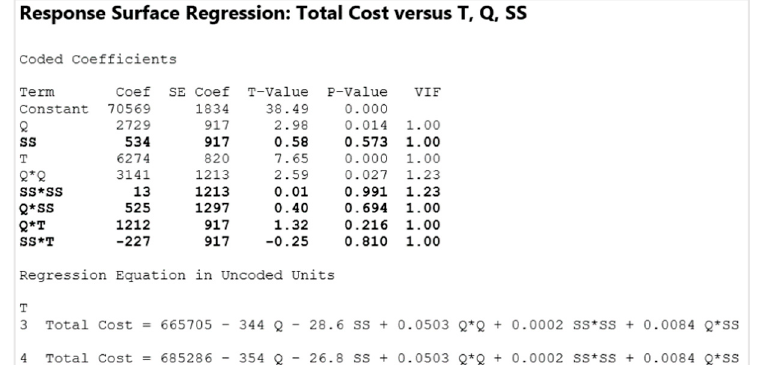
Figure 8. CCD—response surface regression of total cost (TC) versus the period (T), order quantity (Q), and safety stock (SS).